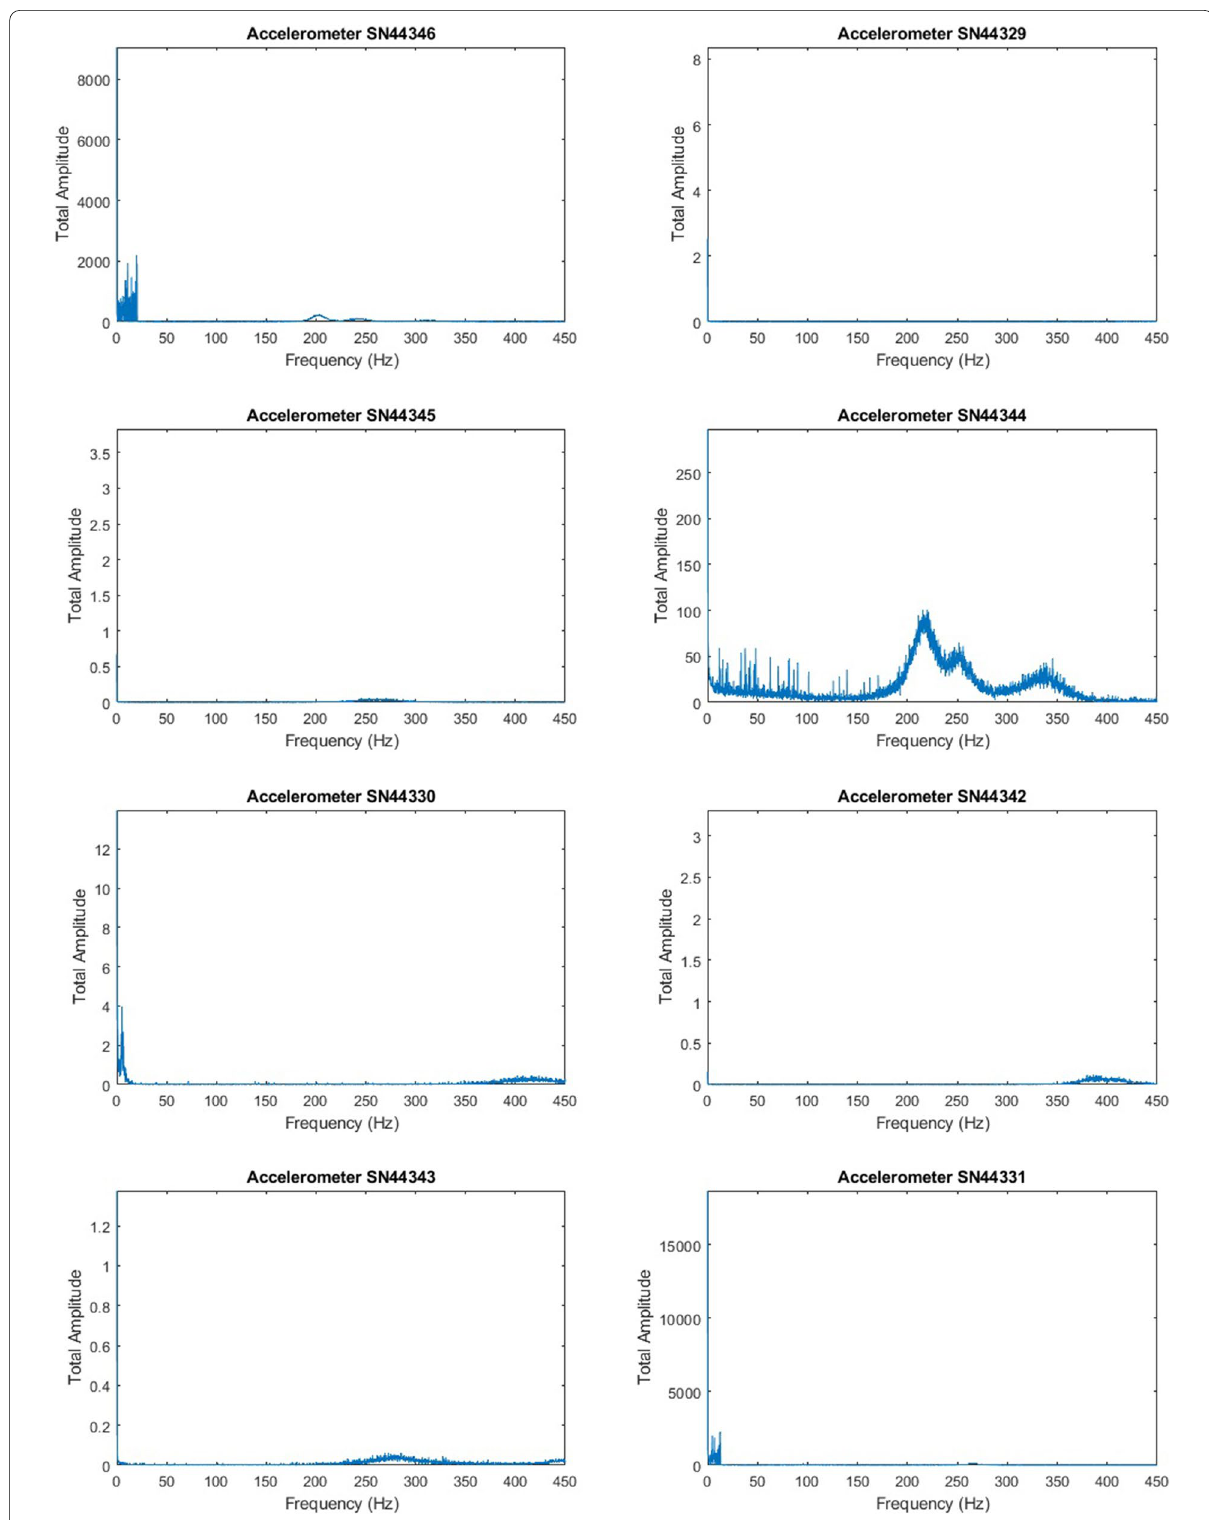
Fig. 7 Frequency spectra of the silo with 300 mm hopper opening – Accelerometer 9 to